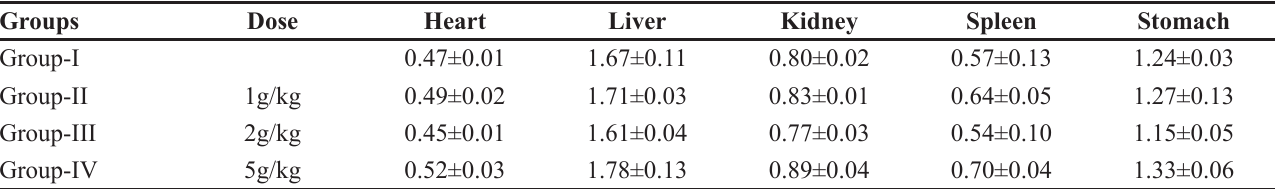
TABLE III - Relative weight of vital body organs of mice Groups Dose Heart Liver Kidney Spleen Stomach Group-I